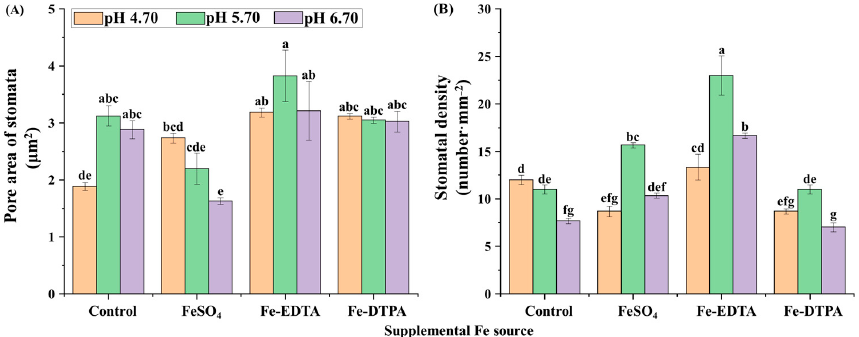
Figure 6. Pore area of the stomata ( A ) and the stomatal density ( B ) in leaves of S. commixta after 6 weeks of culture. Lowercase letters indicate significant differences by the Duncan’s multiple range test at p ≤ 0.05.